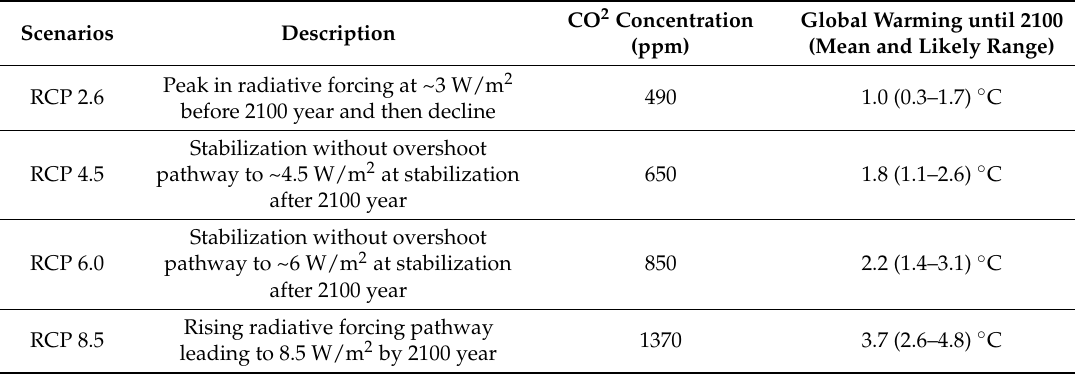
Table 1. RCP (Representative Concentration Pathways) scenario description